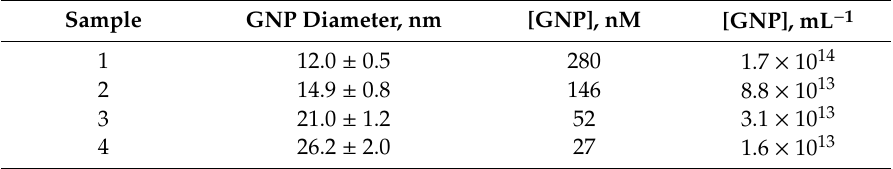
Table 1. Characteristics of gold nanoparticle (GNP) dispersions ( C Au0 = 3 mg/mL).